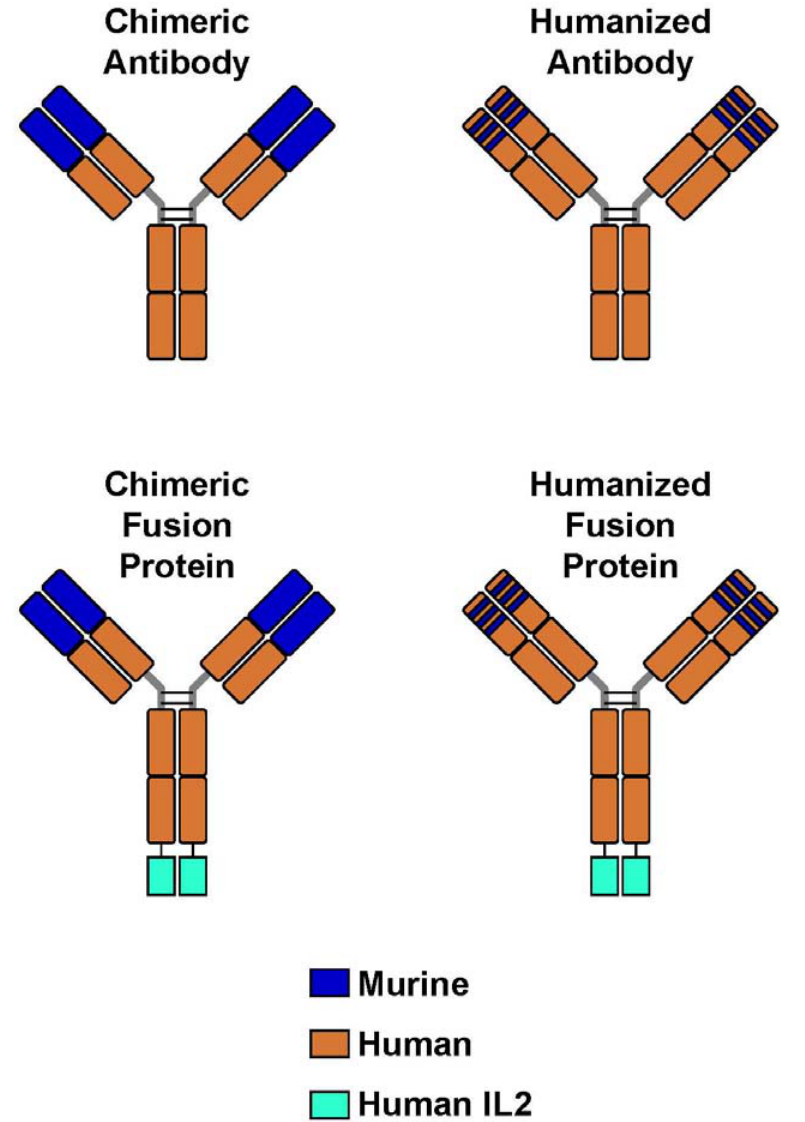
tumors, created by co-injection with the GD2 + B78 melanoma cells (Table 1) [55]. Thus ch14.18-IL2 induces far more potent antitumor effects in melanoma or NBL-bearing mice than the combination of ch14.18 mAb + IL2, and functions both as a T cell inducing vaccine and a potent activator of NK-mediated ADCC. More potent tumor eradication is seen in mice with smaller tumor burdens (Figure 2) [39]. Similar results are seen in murine models using the hu14.18-IL2 IC [58]. As a nearly “pure” human protein it is predicted to be less immunogenic in patients than would ch14.18-IL2. Figure 1. Monoclonal Antibodies and Immunocytokines. ( A ) A chimeric monoclonal antibody (mAb) combines the constant region of a human antibody with the variable domain of a murine antibody. The antigen specificity is conferred by the murine variable domain. ( B ) In the humanized mAb, the murine framework determinants of both the heavy and light chains are replaced with human framework determinants, but the antigen specificity of the original murine mAb is retained. ( C , D ) Immunocytokines combine the mAb with covalently linked cytokines, such as molecules of interleukin 2 (IL-2), in this case to the end of each of the heavy chains at the